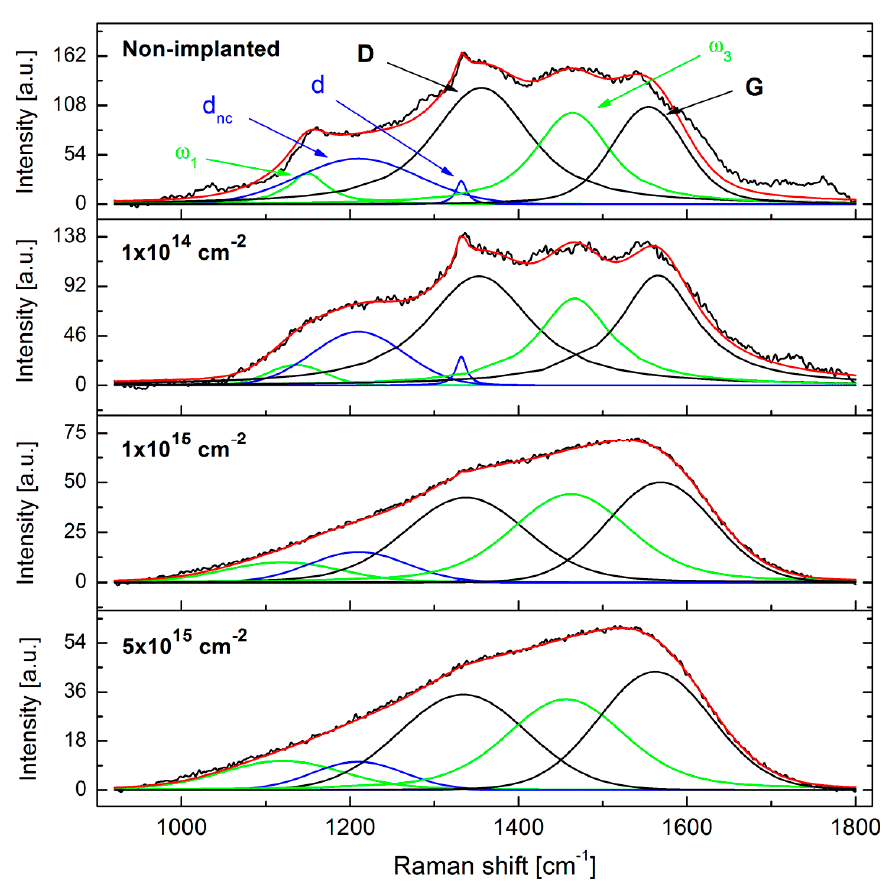
Figure 4. The Raman spectra of NCD films implanted with Er atoms using various implantation fluences—for the comparison also the non-implanted sample is shown. The measured spectra are marked by the black curve, the fitted spectra by the red curve. Various components of the peak-fitting (deconvolution) procedure are depicted using dissimilar colours and labelled in the Raman spectrum of the non-implanted NCD film.